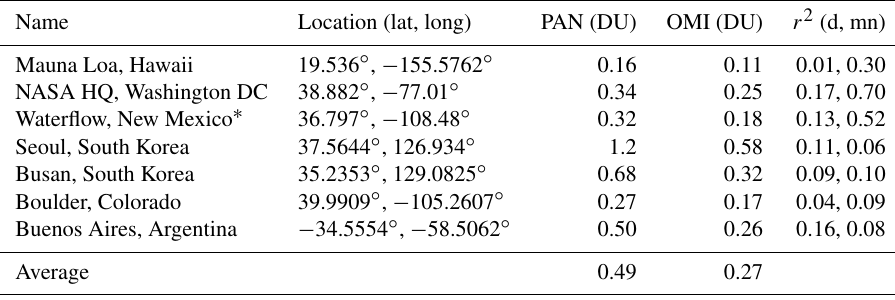
Table 1. Values of TCNO 2 for PANDORA and OMI from monthly averages in Figs. 4 and